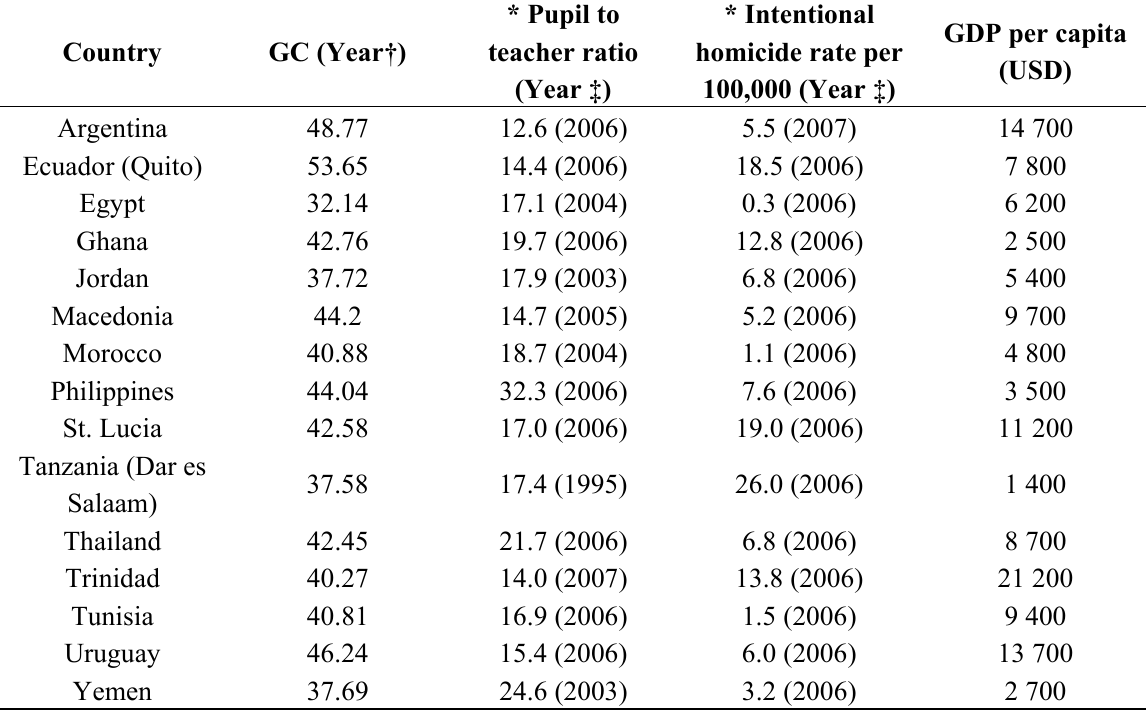
Table 3. Country values included in the analyses of bullied vs . non-bullied adolescents among a sample of low- and middle-income countries (2006–2008). GC, Gini